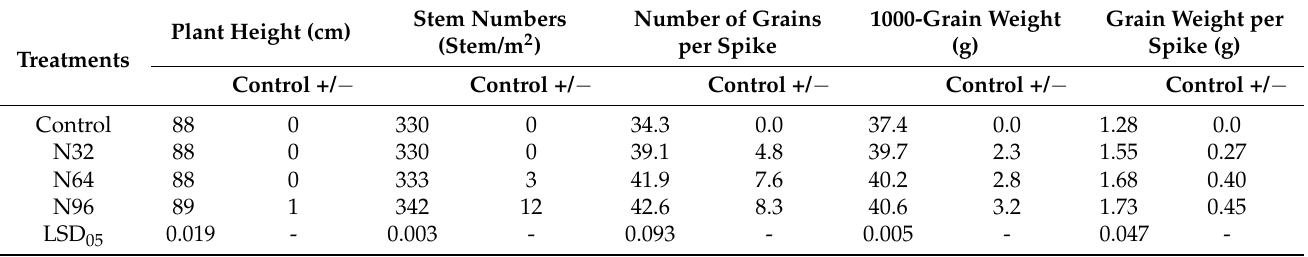
Table 2. Wheat components affected by the influence of nitrogen applications (average for